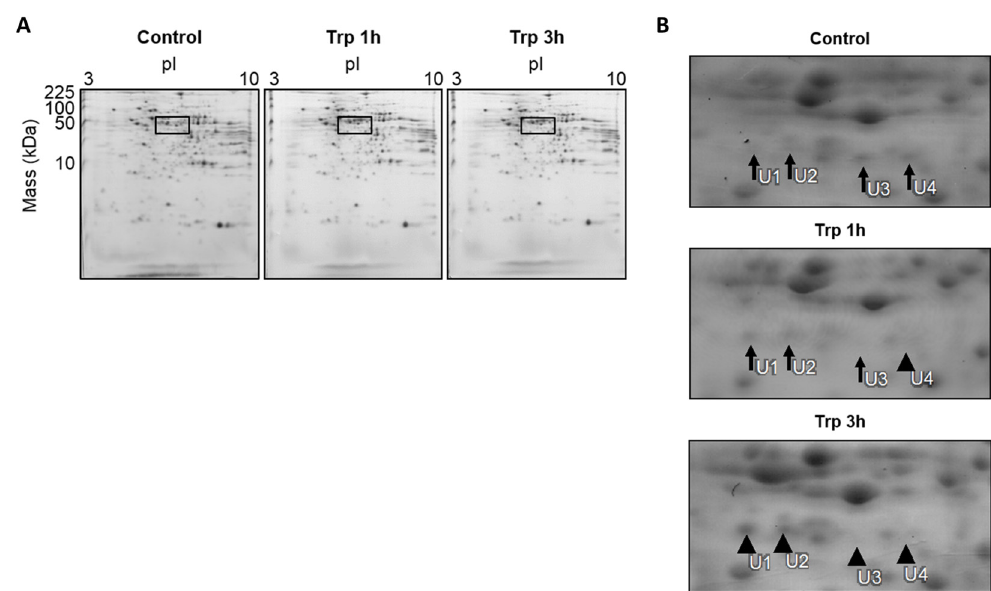
Figure 1. Changes in protein expression in the liver after oral administration of Trp. ( A ) Shown are representative CBB-stained 2-DE gels of whole liver lysate (250 µg of protein for pI 3–10). Control animals were sacrificed after administration of vehicle control. Trp 1 h and Trp 3 h were sacrificed 1 or 3 h after Trp administration (135 mg/100 g body weight), respectively. The region in each gel surrounded with a square contains protein spots differentially up- or downregulated in the Trp-administered group. ( B ) Selected regions of 2-DE gels showing the candidate protein spots U1, U2, U3, and U4. Large arrowheads highlight protein spots that were differentially up- or downregulated by Trp administration. These proteins were identified by in-gel digestion and peptide mass fingerprinting, as shown in Table 3.